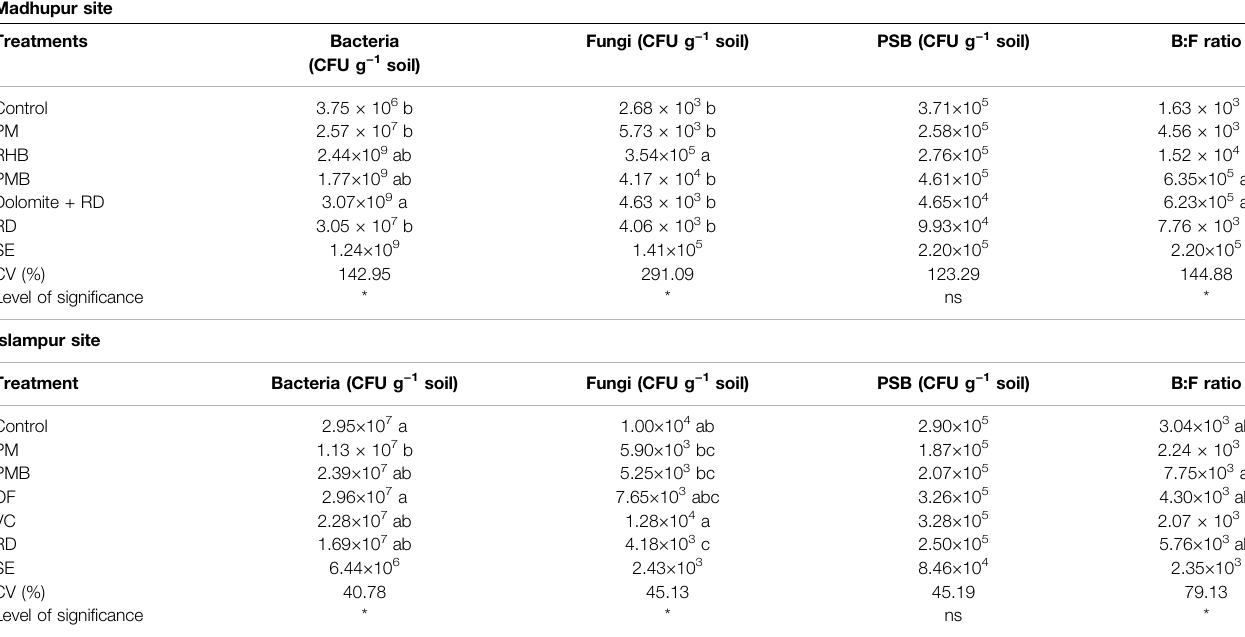
TABLE 6 | Effects of different treatments on microbial population at Madhupur and Islampur sites at a depth of 0 – 15 cm. Madhupur